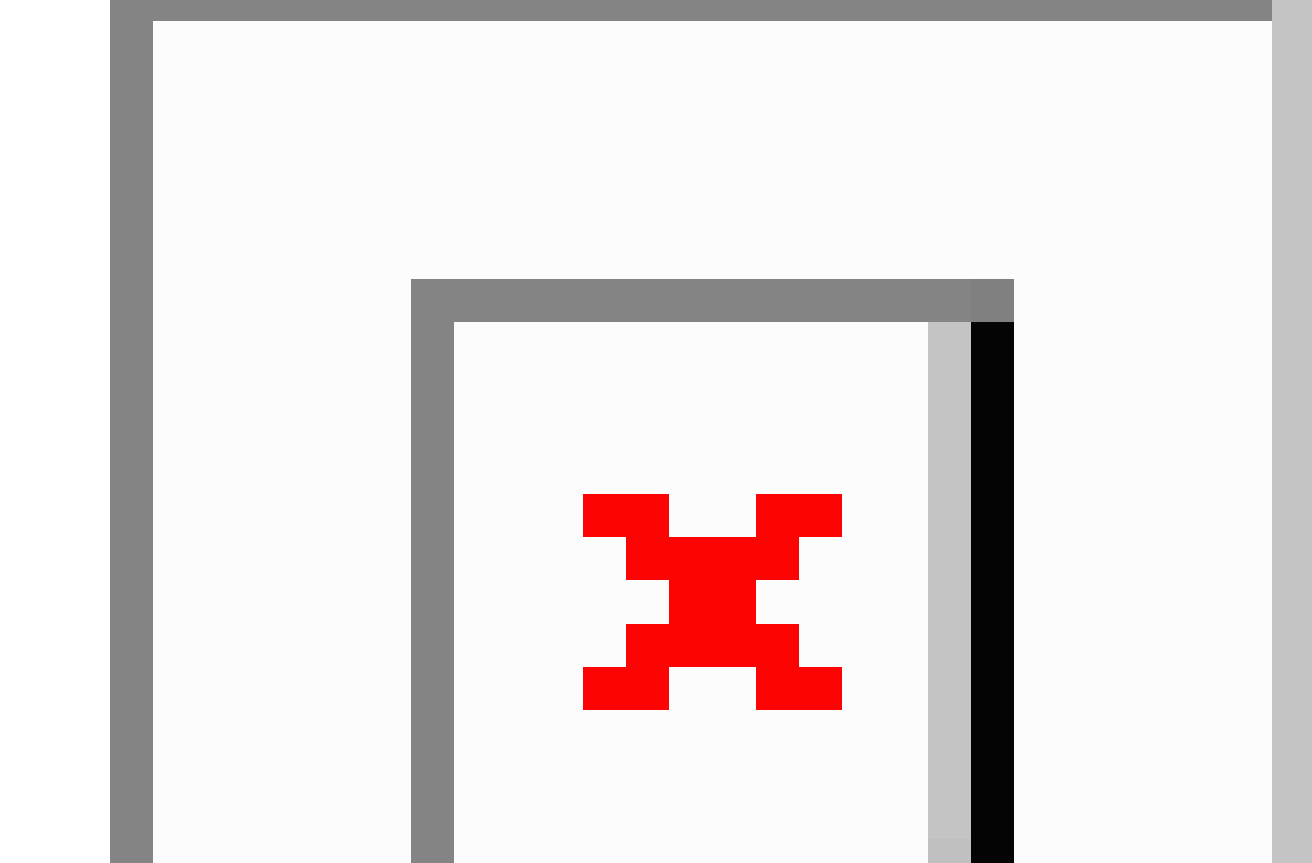
Figure 1. Years with primary care